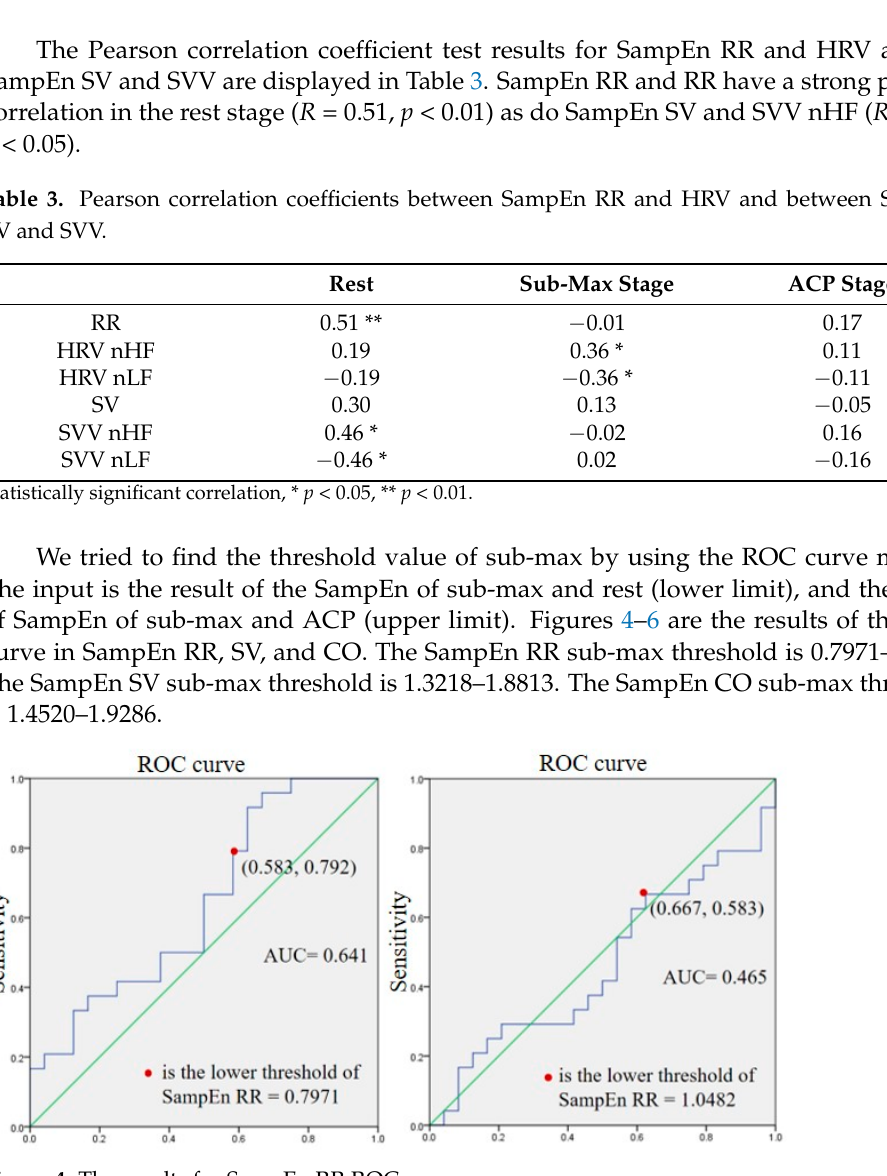
Figure 4. The results for SampEn RR ROC curve.